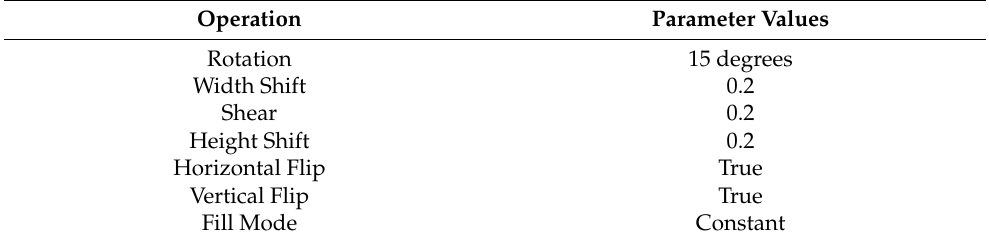
Table 3. Data augmentation.